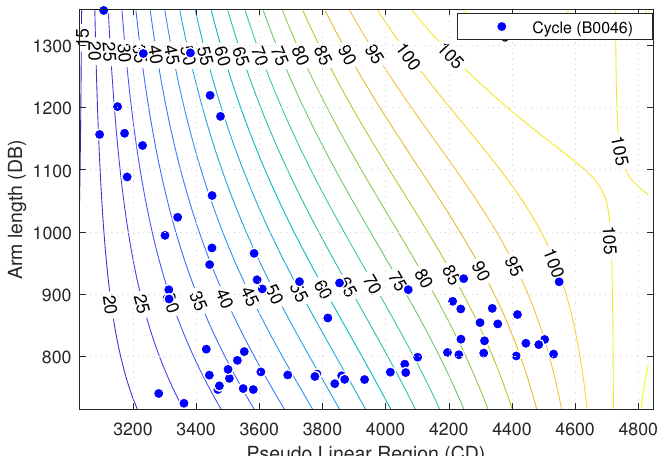
Figure 10. Contour plot showing the effect of cycle number on Arm Length and Pseudo Linear Region at 277.15 K.